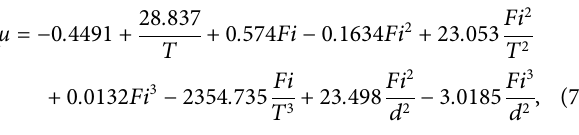
Frontiers in Energy Research |